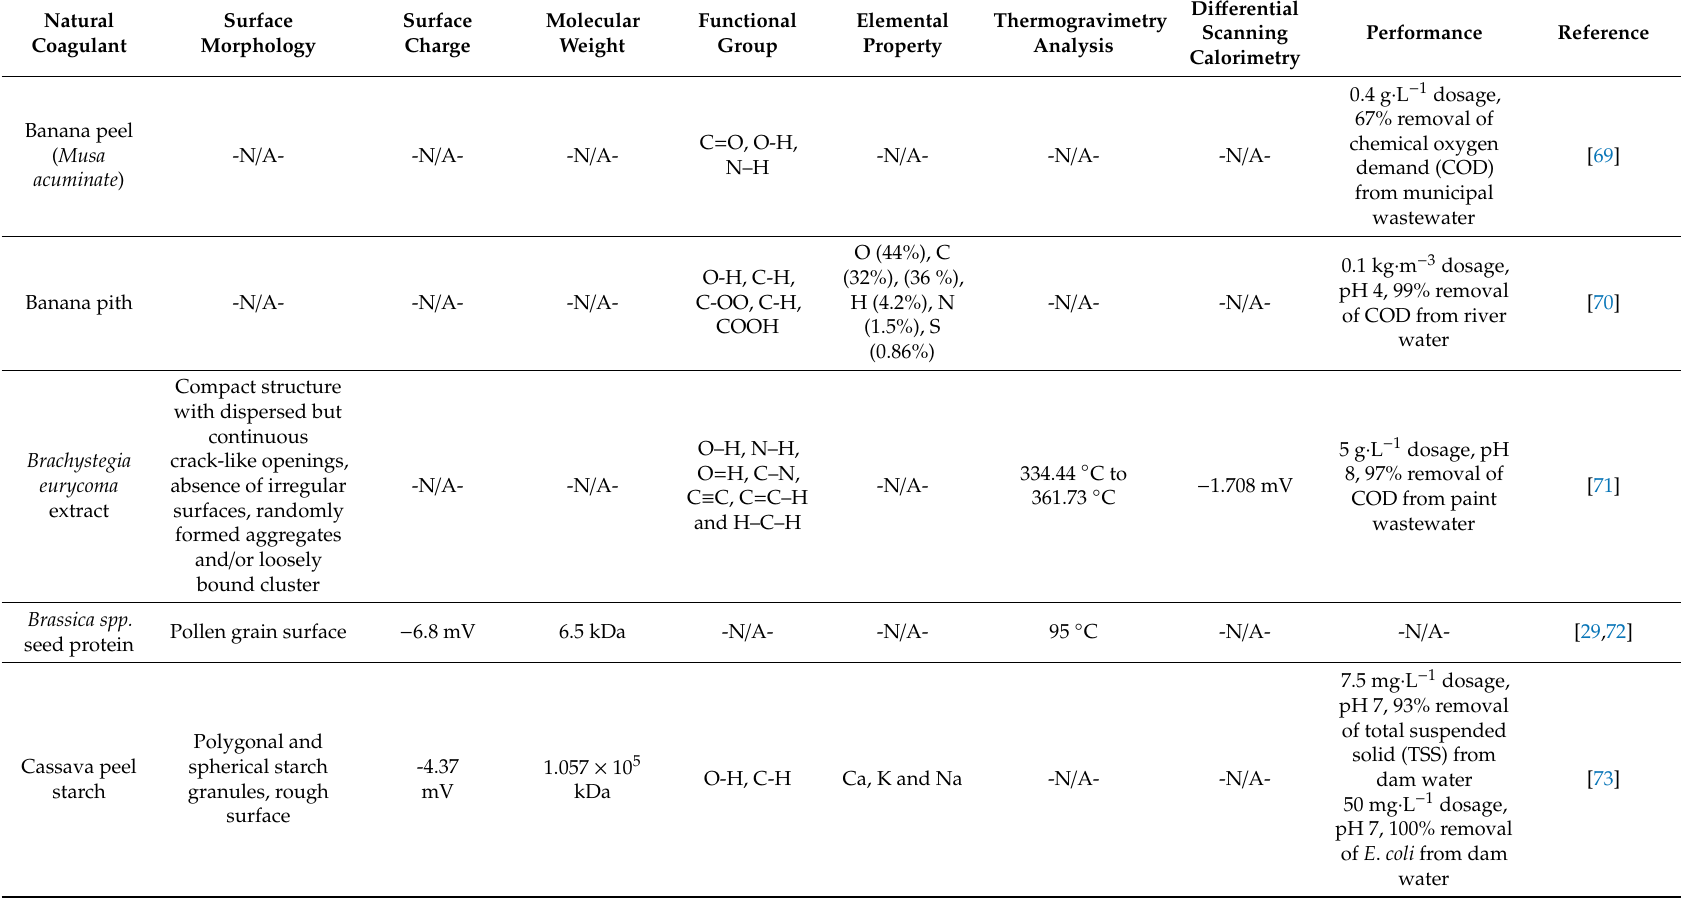
Table 3. Characterisation of natural coagulants and its